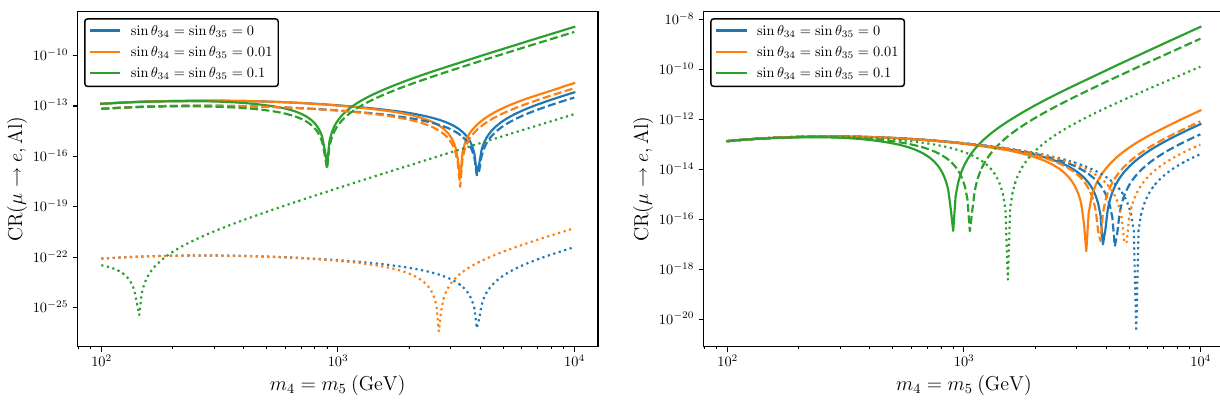
Fig. 8 Neutrinoless μ − e conversion in Aluminium as a function of the degenerate heavy sterile mass, m 4 = m 5 (in GeV). We set θ 1 j = 10 − 3 , θ = 0 . 01, for different values of the tau-sterile mixing angles: θ = 0 (blue), θ = 0 . 01 (orange) and θ = 0 . 1 (green), with j = 4 , 5. On 2 j 3 j 3 j 3 j the left, we set all Majorana phases to zero and consider three choices of the Dirac phase, δ 14 = 0 ,π/ 2 and π , respectively corresponding to solid, dashed and dotted lines. Conversely, on the right panel all Dirac phases are set to zero, and we consider three choices of the Majorana phase, ϕ = 0 ,π/ 4 and π/ 2, corresponding to solid, dashed and dotted lines 4 (ϕ = 0 ) ≈ 850 GeV while modify the value of m c ( m c 4 4 , 5 4 , 5 (ϕ = π/ 2 ) ≈ 1 . 5 m c 4 4 , 5